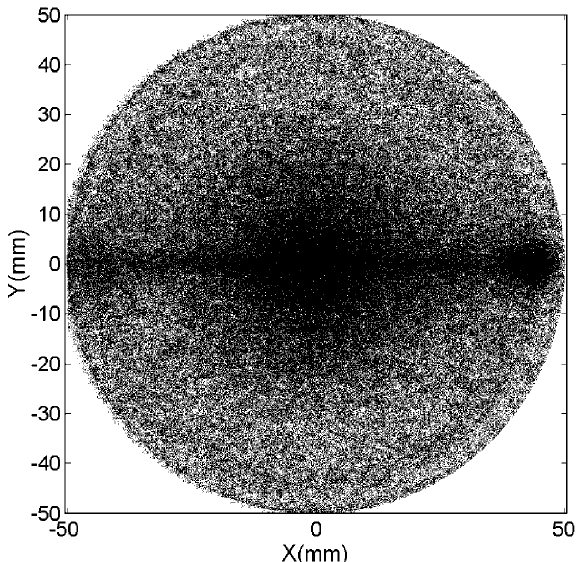
FIG. 7. Electron-cloud distribution in drift region.